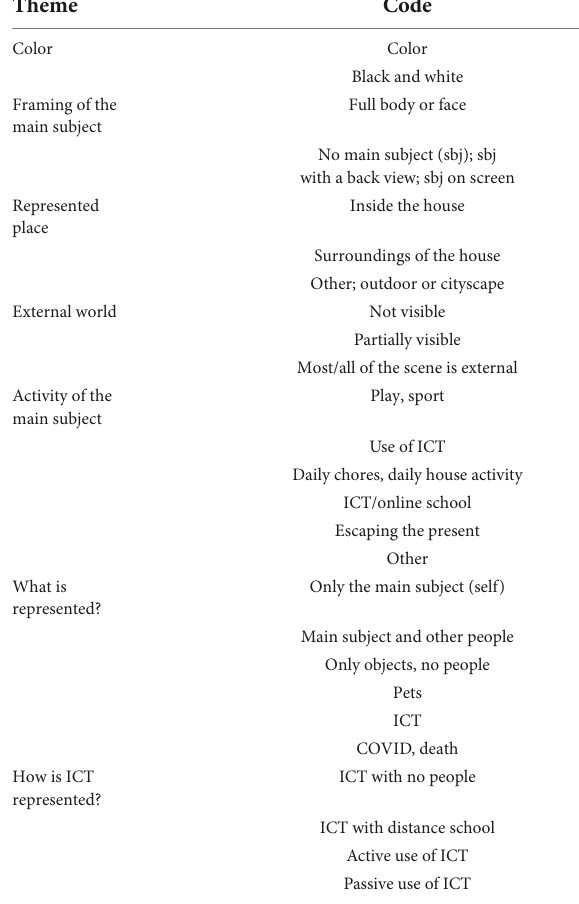
TABLE 1 Overview of the coding scheme developed for the